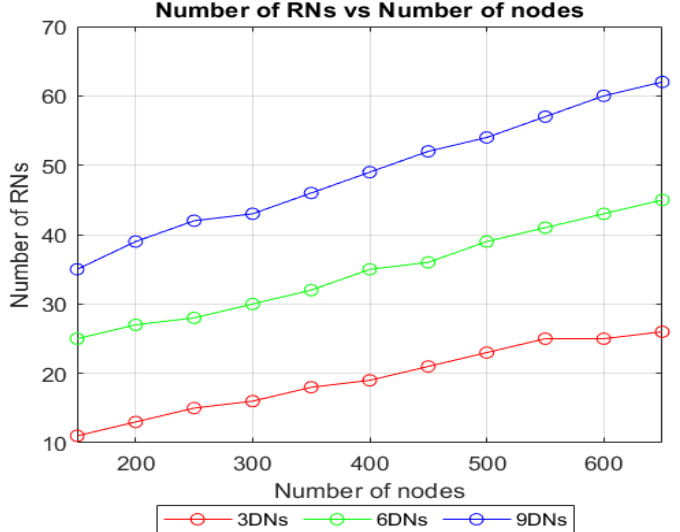
Figure 17. Number of RNs attending each blind spot, increasing with the number of nodes.